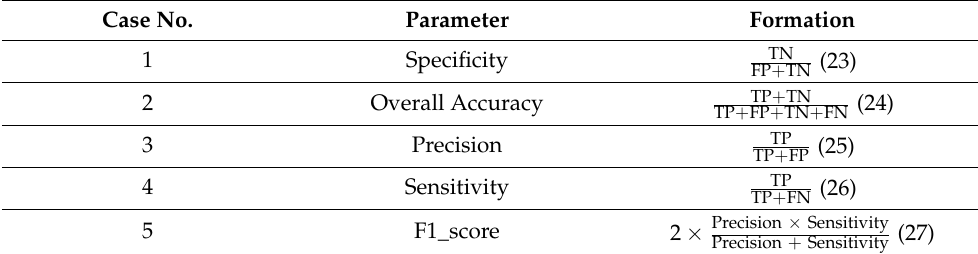
Table 5. Evaluation